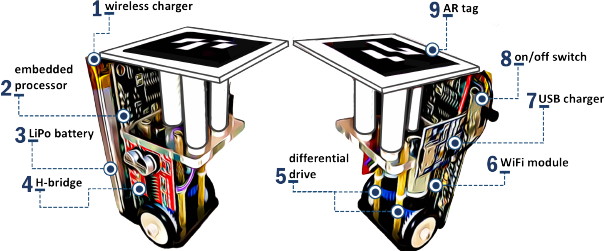
Figure 6. Main components of WsBot: a tiny, low-cost swarm robot [44] (© 2019 IEEE).